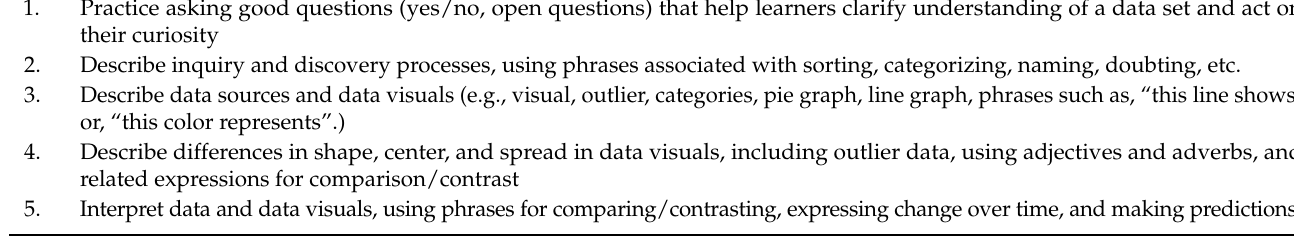
Table 3. Language learning objectives that support “speaking data” in data science (adapted from D’Ignazio & Bhargava,